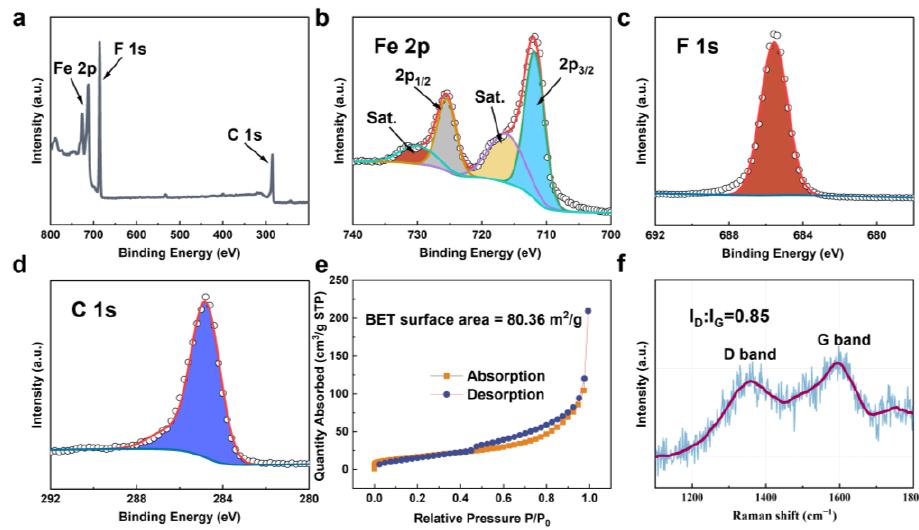
Figure 3. ( a ) XPS survey spectrum of FeF 3 @C and high-resolution of ( b ) Fe 2p, ( c ) F 1s and ( d ) C 1s. The BET surface area ( e ) and Raman spectra ( f ) of the obtained FeF 3 @C